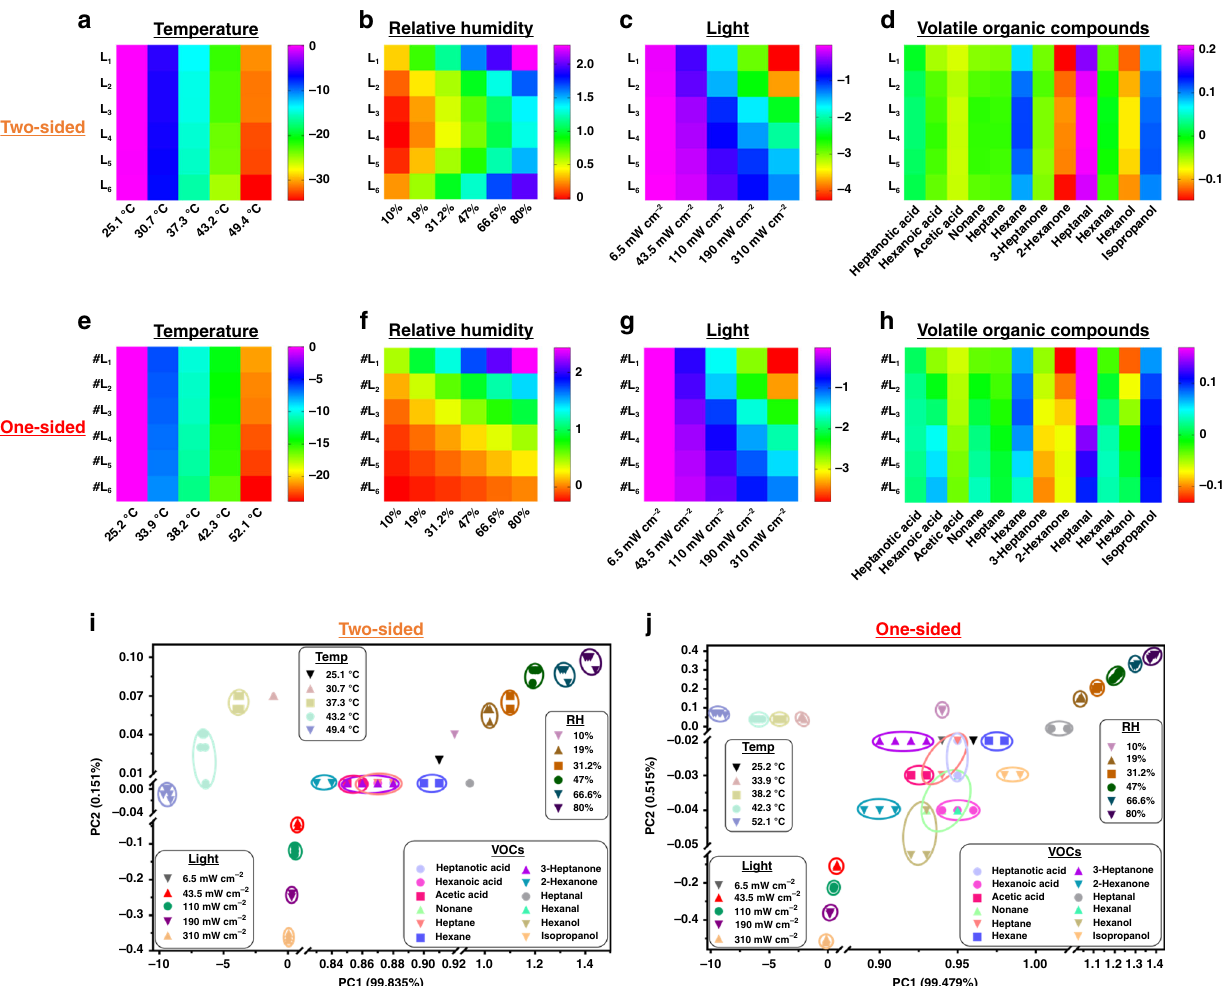
Fig. 3 Origami hierarchical sensor array (OHSA) for the discrimination of multiple chemical and physical stimuli. Color maps represent the responses of two-sided and one-sided OHSA to a , e temperature (~25 – 50 °C), b , f relative humidity (10 – 80%), c , g light (6.5 – 310 mW cm − 2 ), and d , h VOCs (10 ppm), respectively. Two-dimensional canonical score plots of two-sided i and one-sided j OHSA ’ s responses to the multiple stimuli as